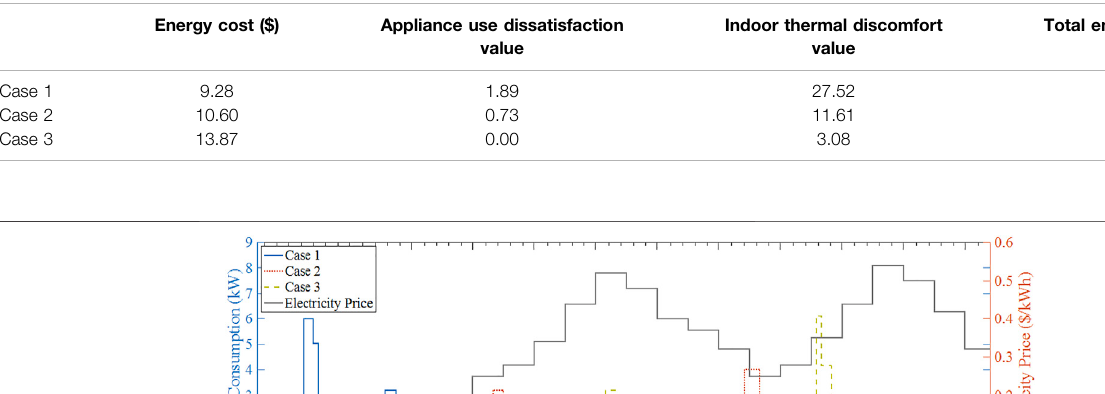
TABLE 3 | Objective values under three cases.